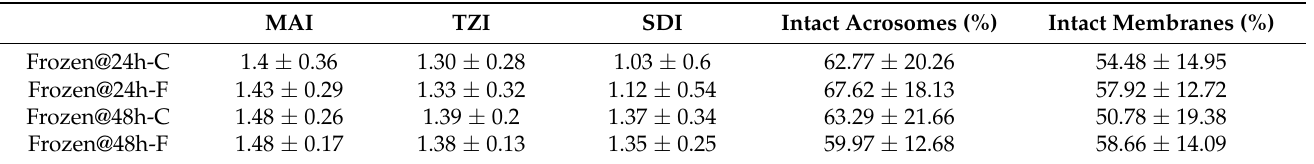
Table 4. Post-thaw morphological features of ejaculated canine spermatozoa after dilution with chilling (C) or freezing extender 1 (F), chilling and storage for 24 or 48 h in a transport box, and Uppsala